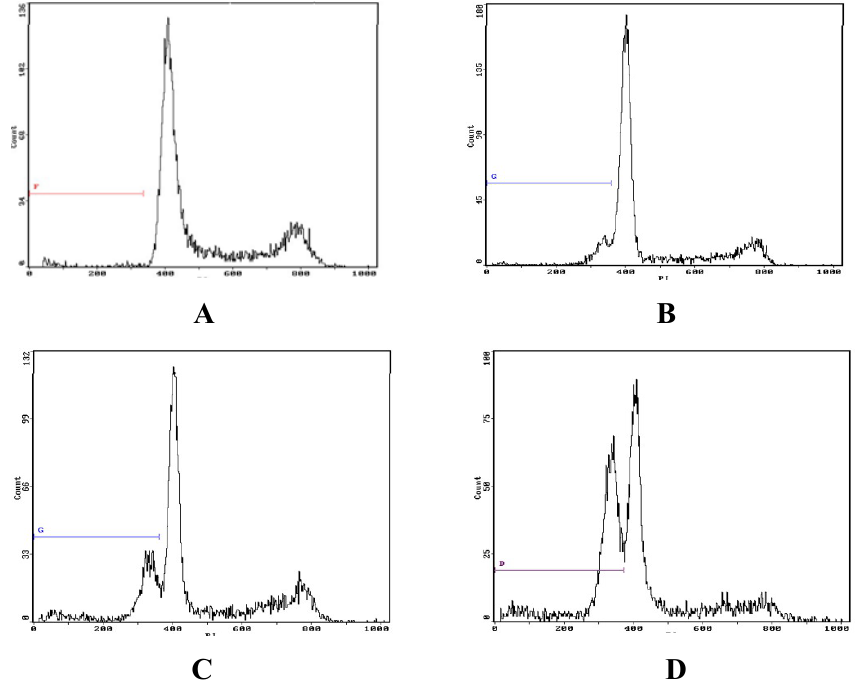
Figure 3. Effects of each group on apoptosis in in human HepG2